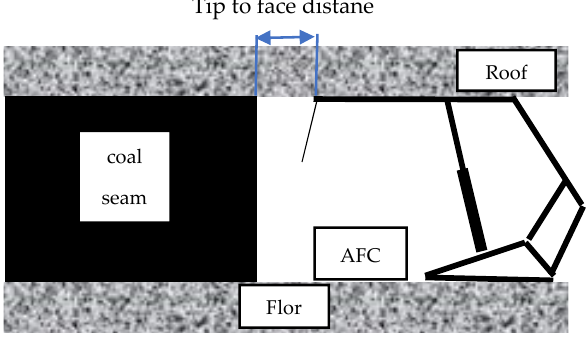
Figure 1. Tip to face distance.